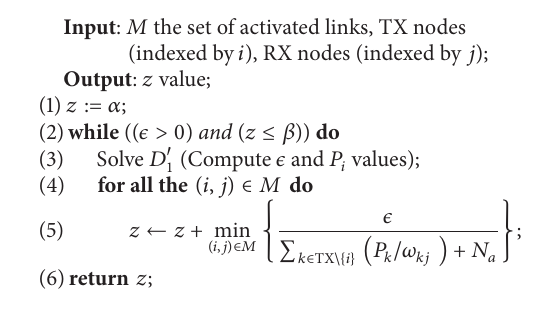
Algorithm 2: Max-min